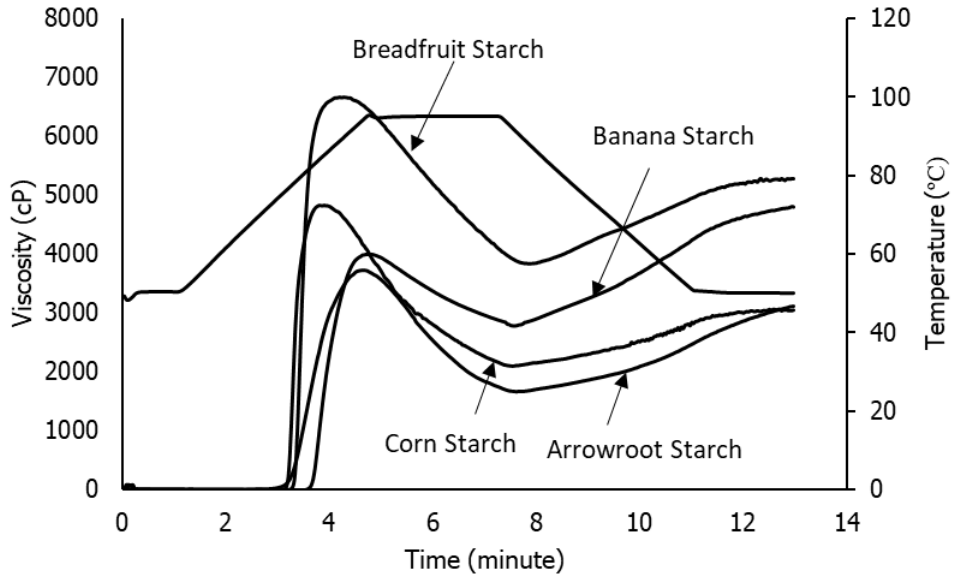
Figure 2. Viscoamylograph of native banana, breadfruit, corn, and arrowroot starches.